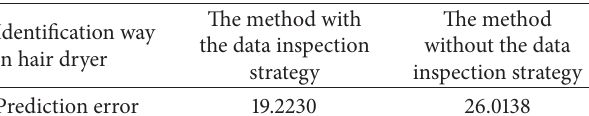
Figure 4: The response comparison in the presence of disturbance after the model changes. Table 2: The prediction errors with and without the data inspection strategy in the hair dryer example.